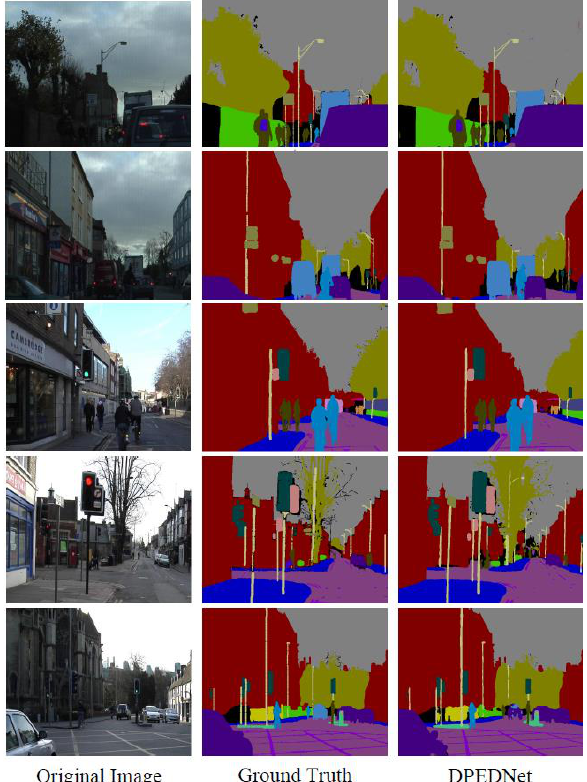
Figure 2. Qualitative examples of the semantic segmentation on CamVid